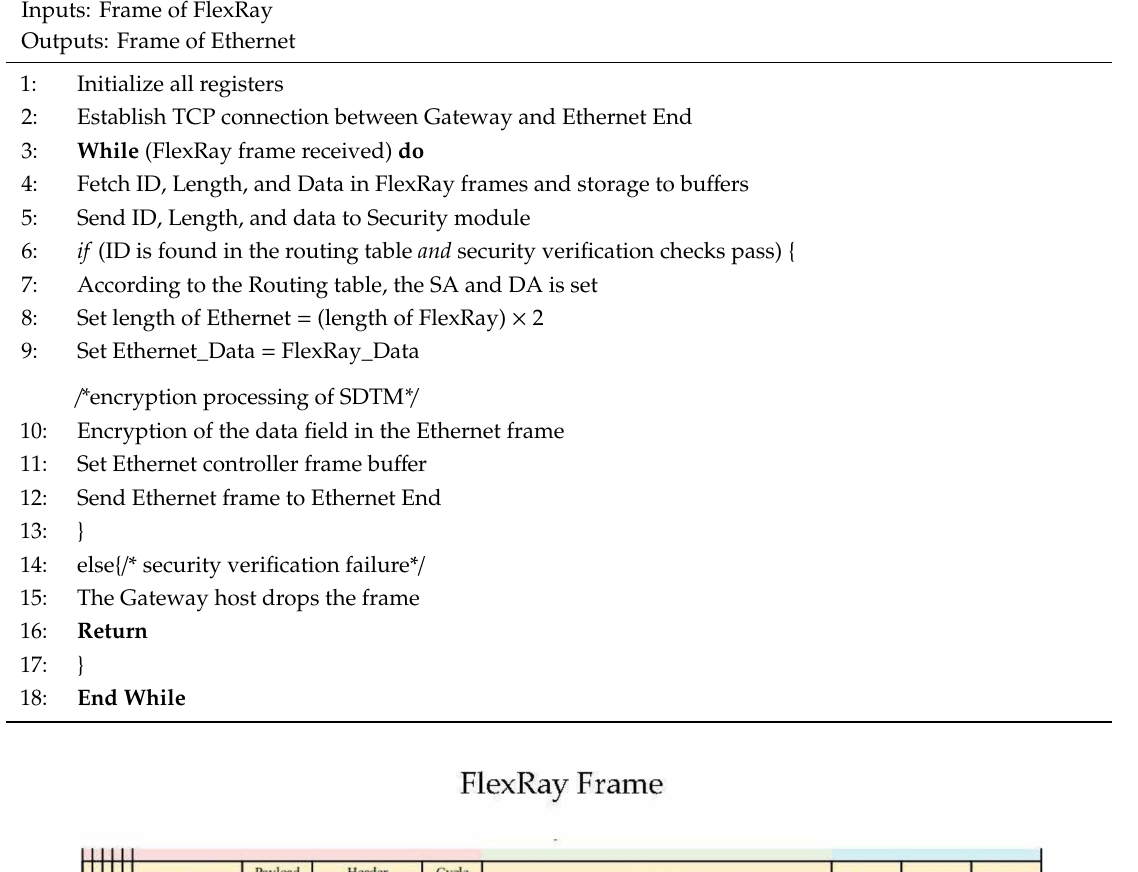
Algorithm 1. Data path from FlexRay to Ethernet